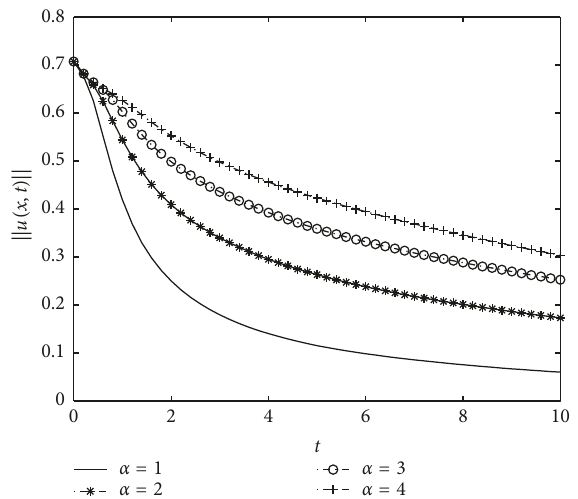
Figure 6: The L 2 -norm of u ( x,t ) , ‖ u ( x,t )‖ , over time for various values of α when applying the second nonlinear adaptive controller μ � 0 . 001, ] � 0 . 01, c